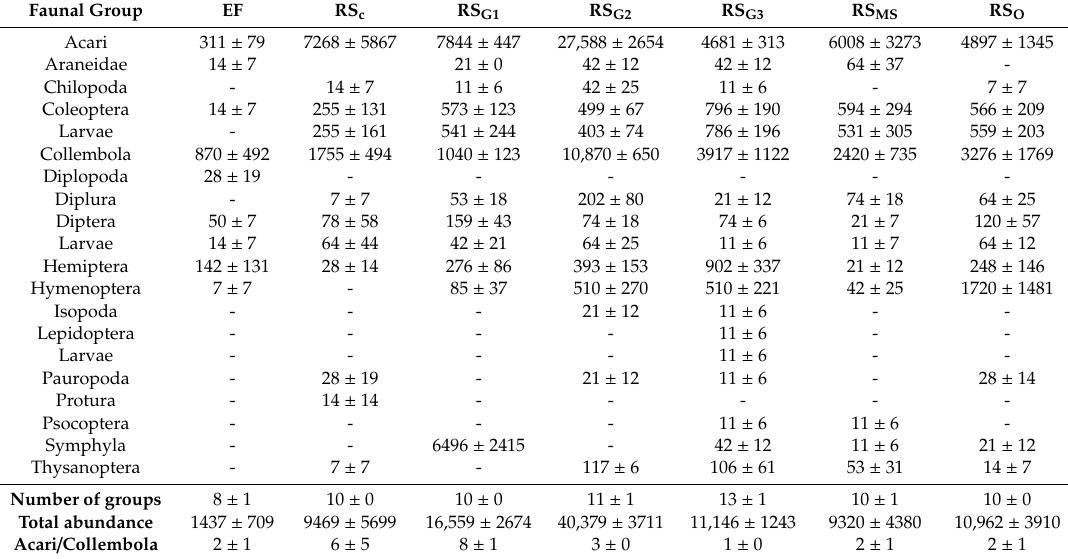
Table 2. Average ± standard error of the number of individuals (ind. / m 2 ) for each faunal group, the number of groups, the total abundance (ind. / m 2 ) and the ratio Acari / Collembola found in the seven sites studied.